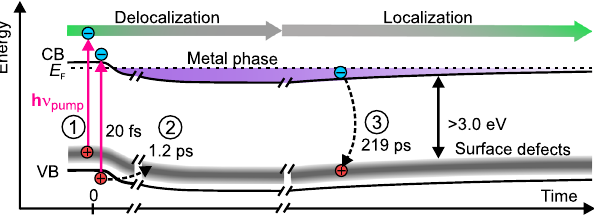
Fig. 5 Scheme of the pump-induced processes. Photoexcitation resonant to the ZnO band gap populates the CB and depopulates surface defect states leading to downward surface BB; above the threshold fl uence F C the electrons delocalize and form the metal phase (process 1). Delayed increase of the BB occurs due to hole trapping at surface defect sites (process 2). The PIPT recovers as the surface charge is reduced by electron-hole recombination (process